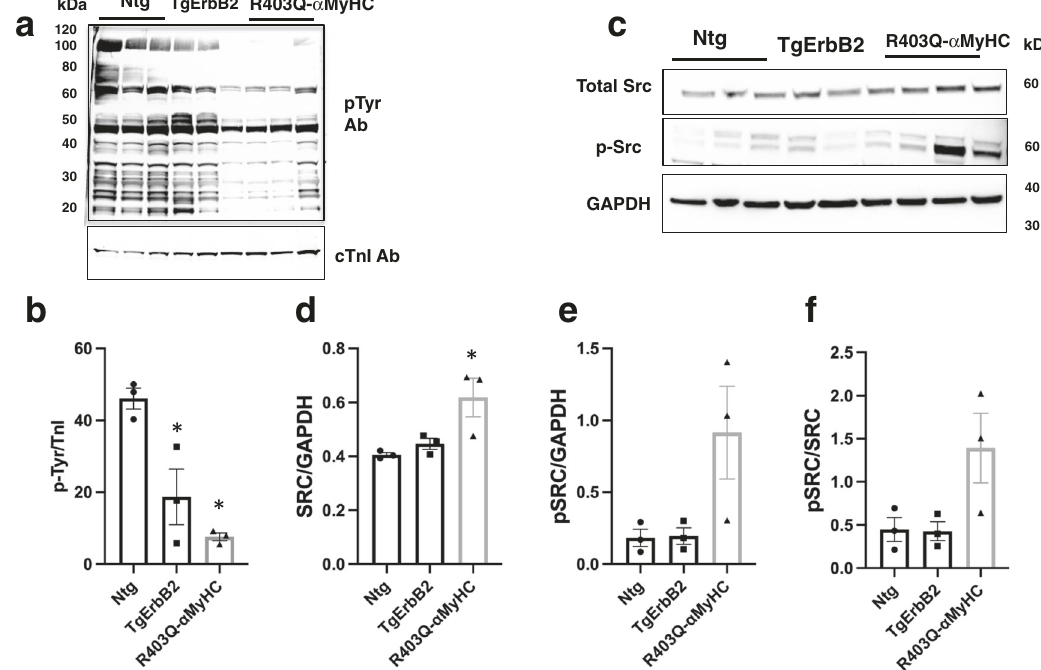
Fig. 1 Global pTyr is reduced in cardiac hypertrophy associated with ErbB2 overexpression or myosin heavy chain mutation. a Western Blots show a decrease in pTyr on TgErbB2 ( p = 0.0298) mice and R403Q- α -MyHC ( p = 0.003) heart homogenates. The Troponin I signal shows corresponding total protein loading. b Densitometry analysis shows that after the pTyrosine signal was normalized to total cTnI, the TgErbB2 and R403Q- α -MyHC mice signi fi cantly decreased in pTyr. c Western Blots show expression levels of total Src and p-Src (Tyr 416) and GAPDH as a loading control. d Densitometry analysis revealed that Src levels are signi fi cantly elevated in R403Q- α -MyHC (p = 0.0282), whereas e and f Show that p-Src phosphorylation levels are elevated in R403Q- α -MyHC but did not reach statistical signi fi cance. Signals in d and e were normalized to total GAPDH, whereas in f pSRC was normalized to total SRC. Ntg ( n = 3), TgErbB2 ( n = 3), and R403Q- α -MyHC ( n = 3), error bars represent S.E.M. One-way ANOVA was used to compare